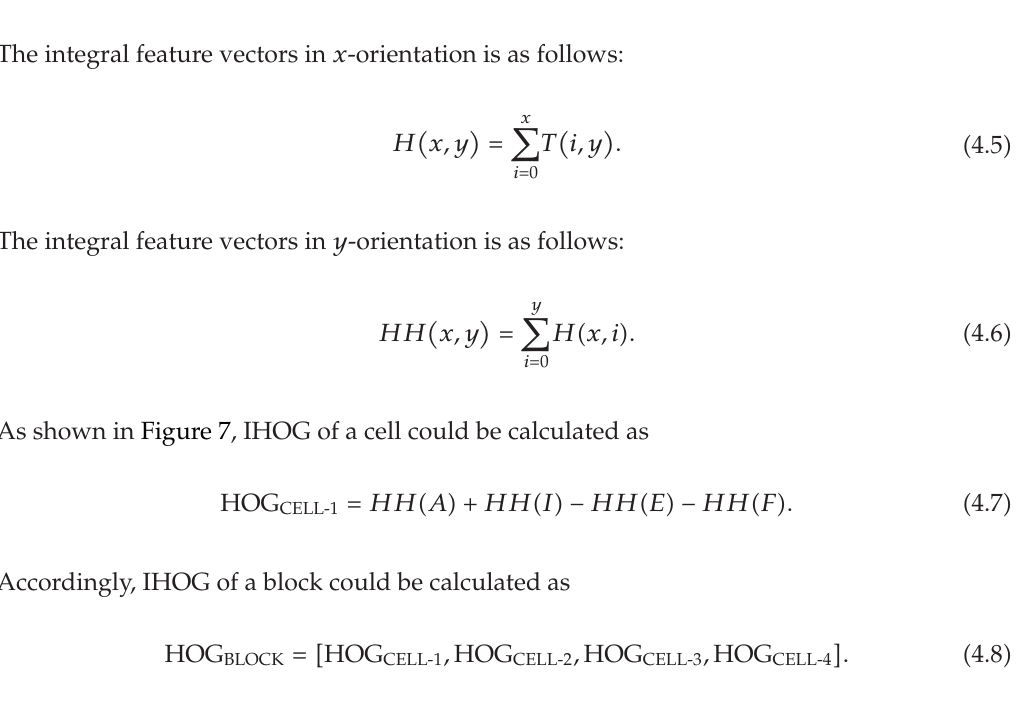
Figure 7: IHOG calculation of a